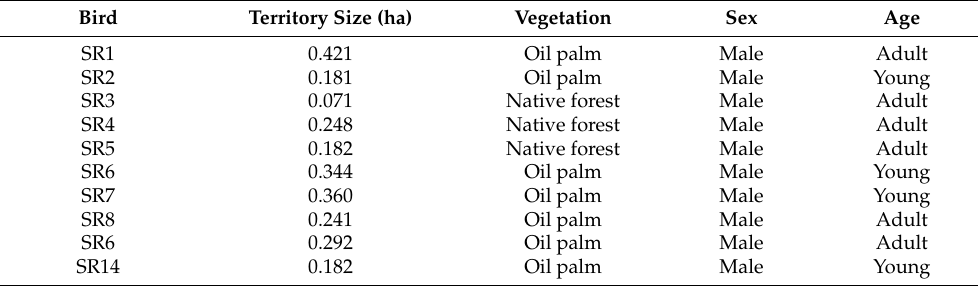
Table 1. Territory size estimates of territorial American Redstarts ( Setophaga ruticilla ) during the non-breeding season in Tabasco, Mexico. Two estimates for the individual SR6 are reported, each one for a different